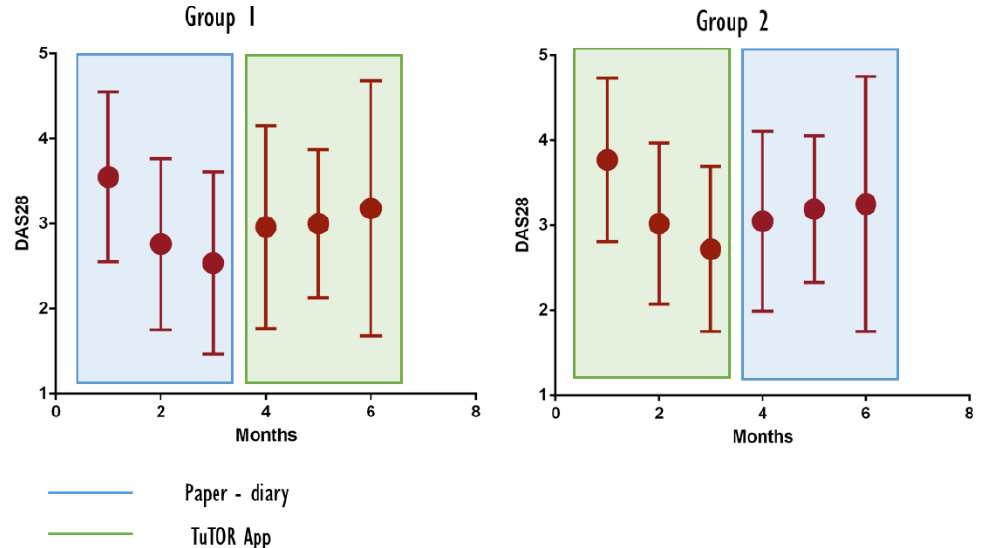
Figure 3. Decrease in disease activity assessed by DAS28 in the paper diary and TuTOR app groups.